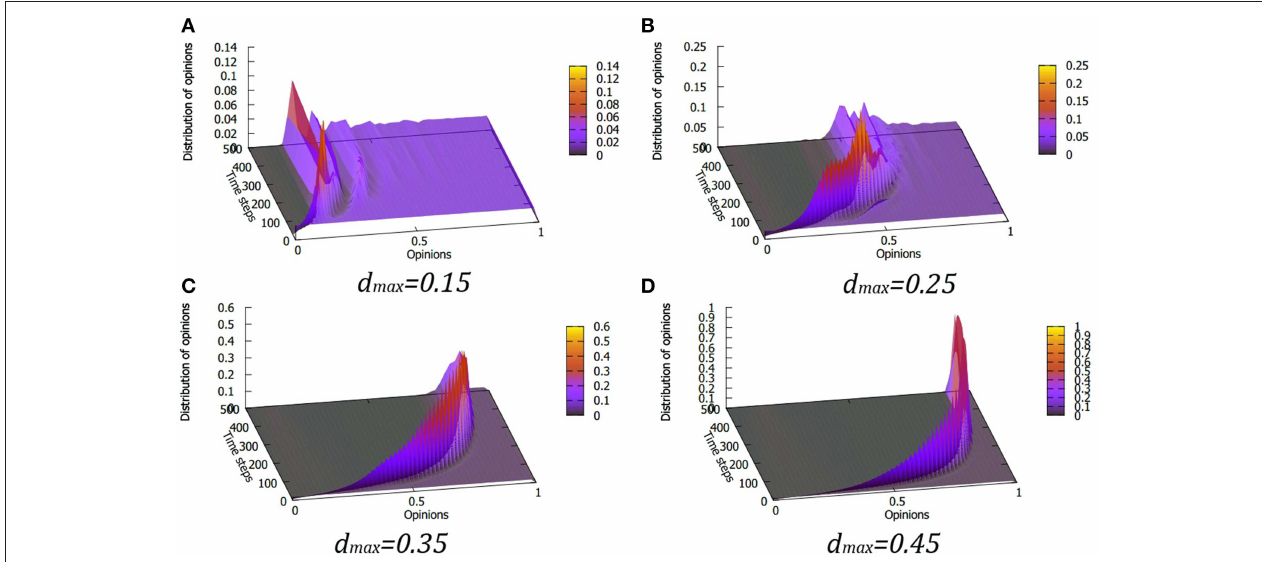
FIGURE 5 | Evolution of opinion distribution for various values of the maximum tolerance d max for the linear form of the Equation (5), i.e., L = 1 , for the mood factor m = 0 . 5 . Panels (A–D) correspond to d max values of 0.15, 0.25, 0.35 and 0.45, respectively.